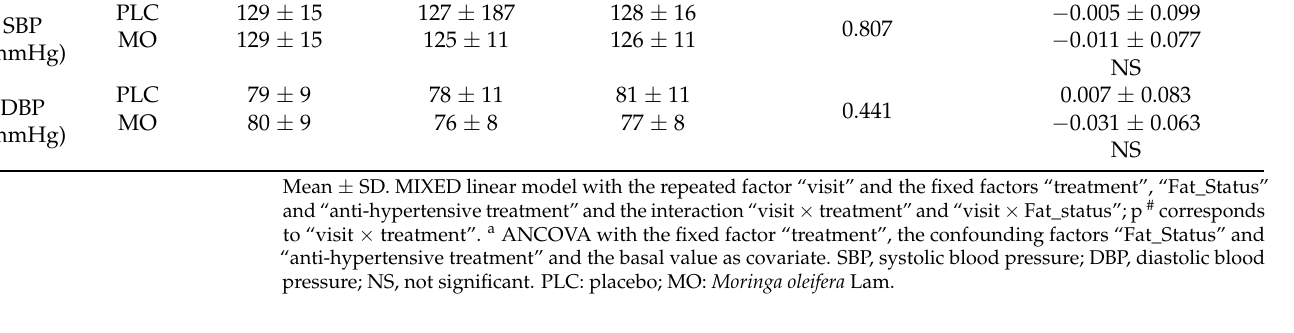
Table 6. Intestinal health markers in fecal samples of patients with prediabetes of the PLC and MO groups during the intervention.